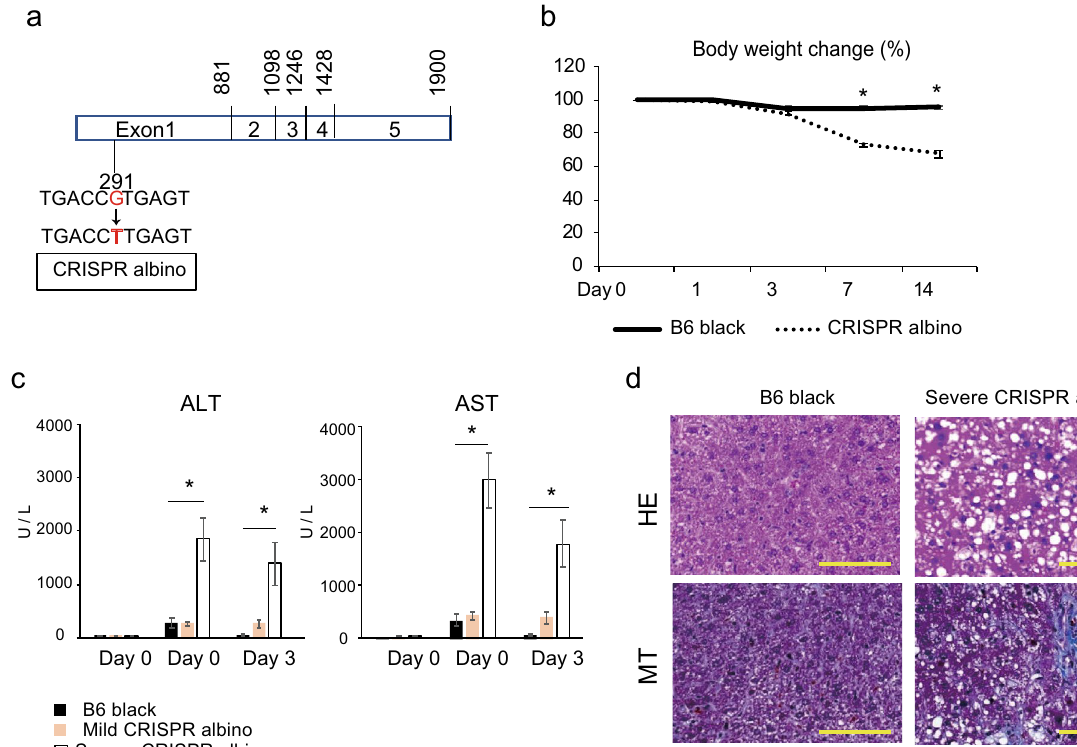
Figure 4. Mice with Tyrosinase c.291G > T mutation show the same phenotype to B6 albino with HCD feeding. ( a ) Tyrosinase transcript. CRISPR albino with C.291G > T mutation in Tyrosinase of C57BL/6J mouse using CRISPR/Cas9 system. ( b ) Transition graph of weight with HCD feeding in B6 black group and CRISPR albino group. ( c ) Serum ALT and AST values of B6 black group (black bar), mild CRISPR albino group (beige bar) and severe CRISPR albino group (white bar) with HCD feeding. ( d ) Liver histology of each group on day 14 of HCD feeding. Steatosis, inflammatory cell accumulation and fibrosis only observed in severe CRISPR albino livers. All the data are presented as the mean ± s.e.m. * p < 0.05 severe CRISPR albino (n = 7) compared with B6 black (n = 5) (Welch’s